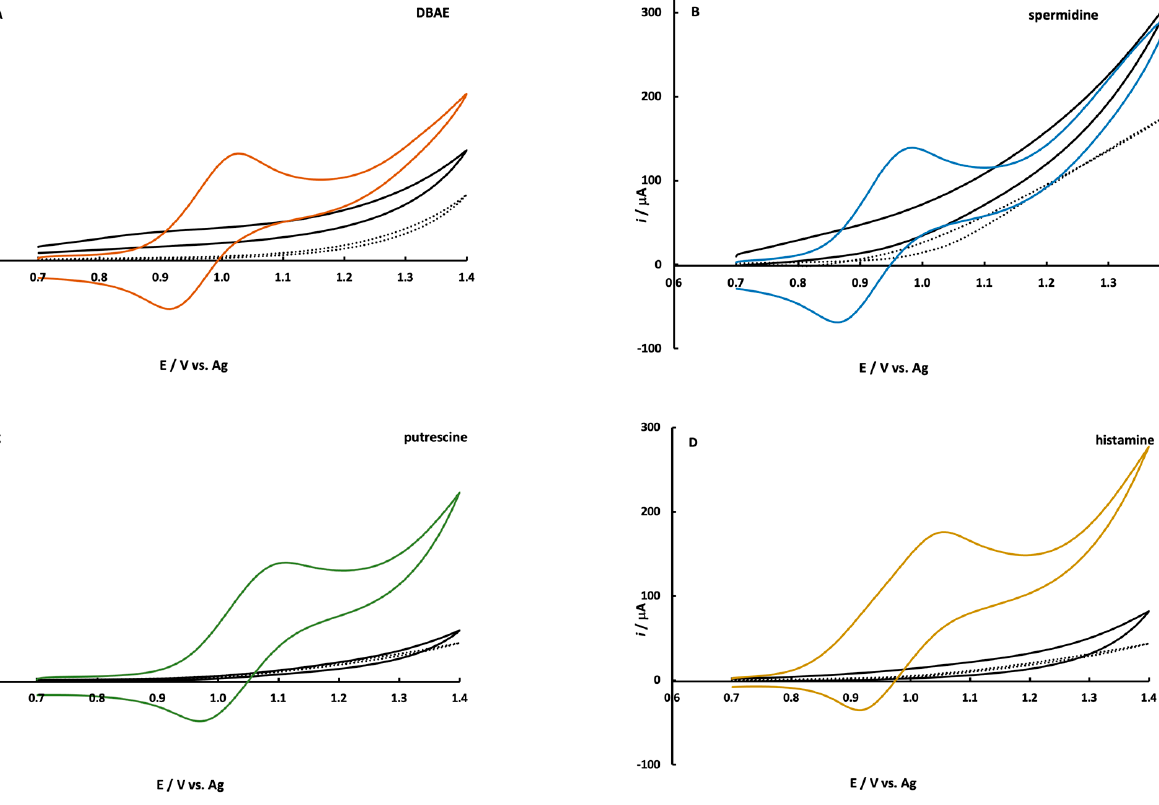
Figure 3. Cyclic voltammograms of 5.0 mM Ru(bpy) 32+ plus ( A ) 0.85 mM DBAE, ( B ) 1.35 mM spermidine both in pH 7.4 PBS; ( C ) 1.35 mM putrescine, and ( D ) 1.35 mM histamine both in pH 9.0 borate buffer. The black line corresponds to a 2.0 mM solution of each amine and the dotted line is the background scan. All CV’s were collected at a scan rate of 0.1 V/s.